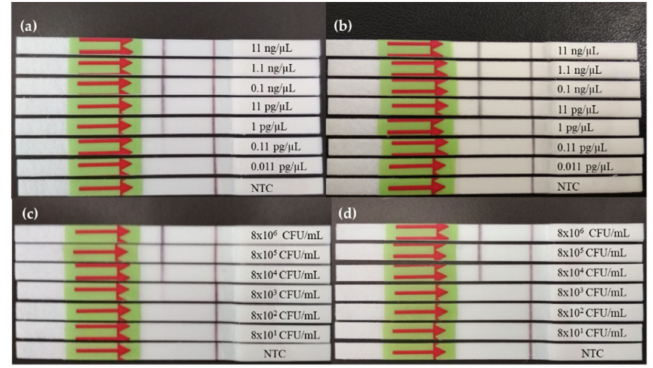
Figure 1. Dynamic range of L. monocytogenes detection for RPA-LF reaction. ( a ) and ( b ) show